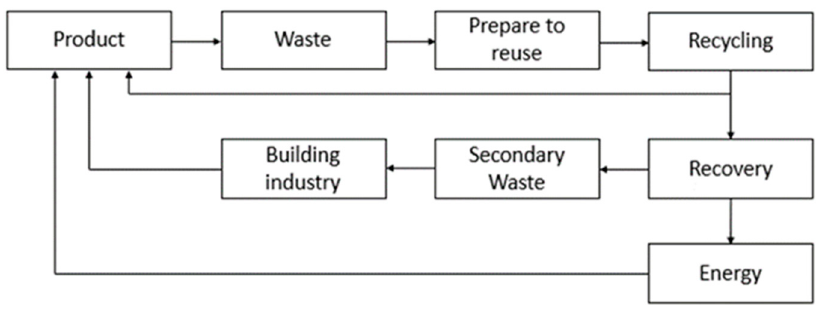
Figure 3. Ideal circular economy.